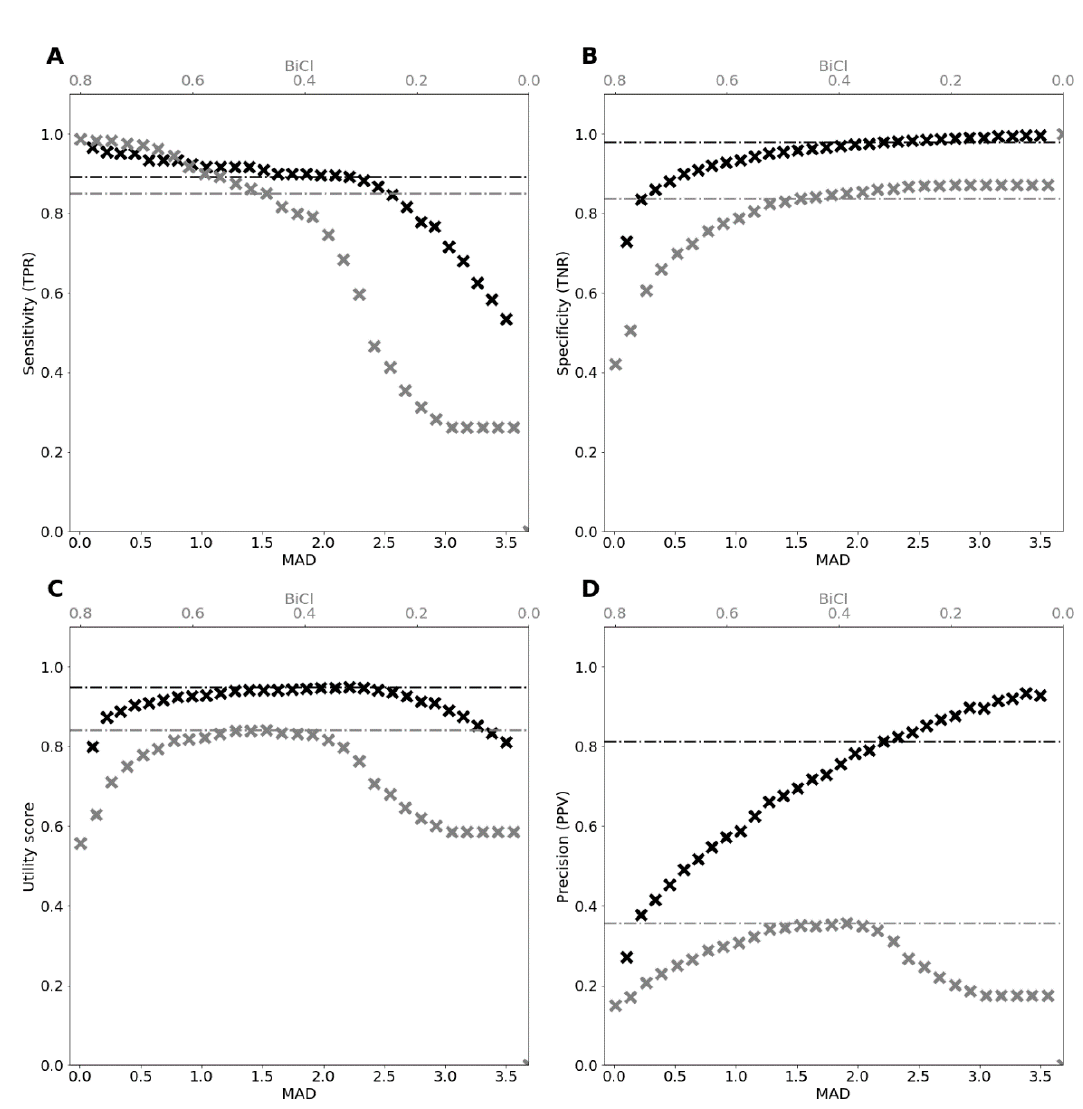
Figure 7. Evaluation of our model (MAD) on a held-out test set (2540 sentence pairs, 10% misaligned sentences) from the labeled dataset for misalignment detection described in Section 2.1. Black crosses show performance for various thresholds of MAD; gray crosses show performance for various BiCleaner thresholds. Note that a misalignment is considered a positive label. Horizontal, dotted black and gray lines show performance for MAD resp. BiCleaner thresholds for which the utility score is maximal. ( A ) Sensitivity for various MAD (black, lower x -axis) and BiCleaner (gray, upper x -axis) thresholds. ( B ) Specificity. ( C ) Utility score. ( D ) Precision.